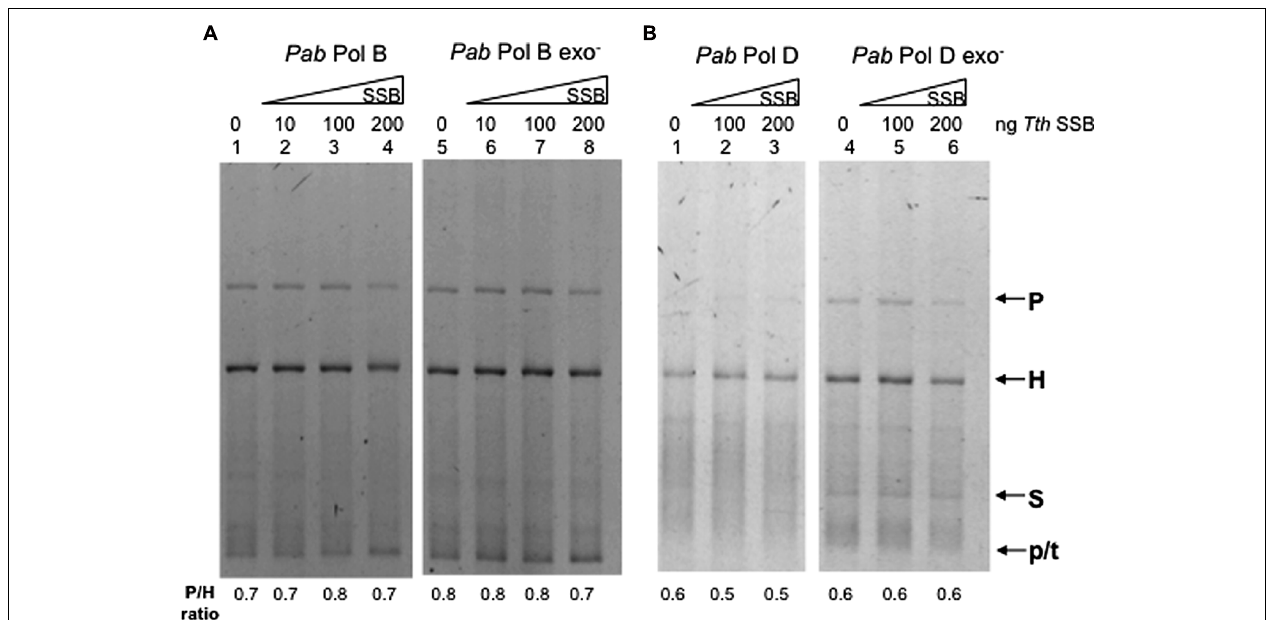
Pab PolD and Pab PolD exo- (4.3 and 5.2 pmol respectively, B ), and were pre-incubated at 60 ◦ C with increasing concentrations of T. thermophilus SSB (1 ng of Tth SSB corresponds to 16.78 fmol). P, H, S, and p/t refer to parental heteroduplex. stalled molecules and primer-template,